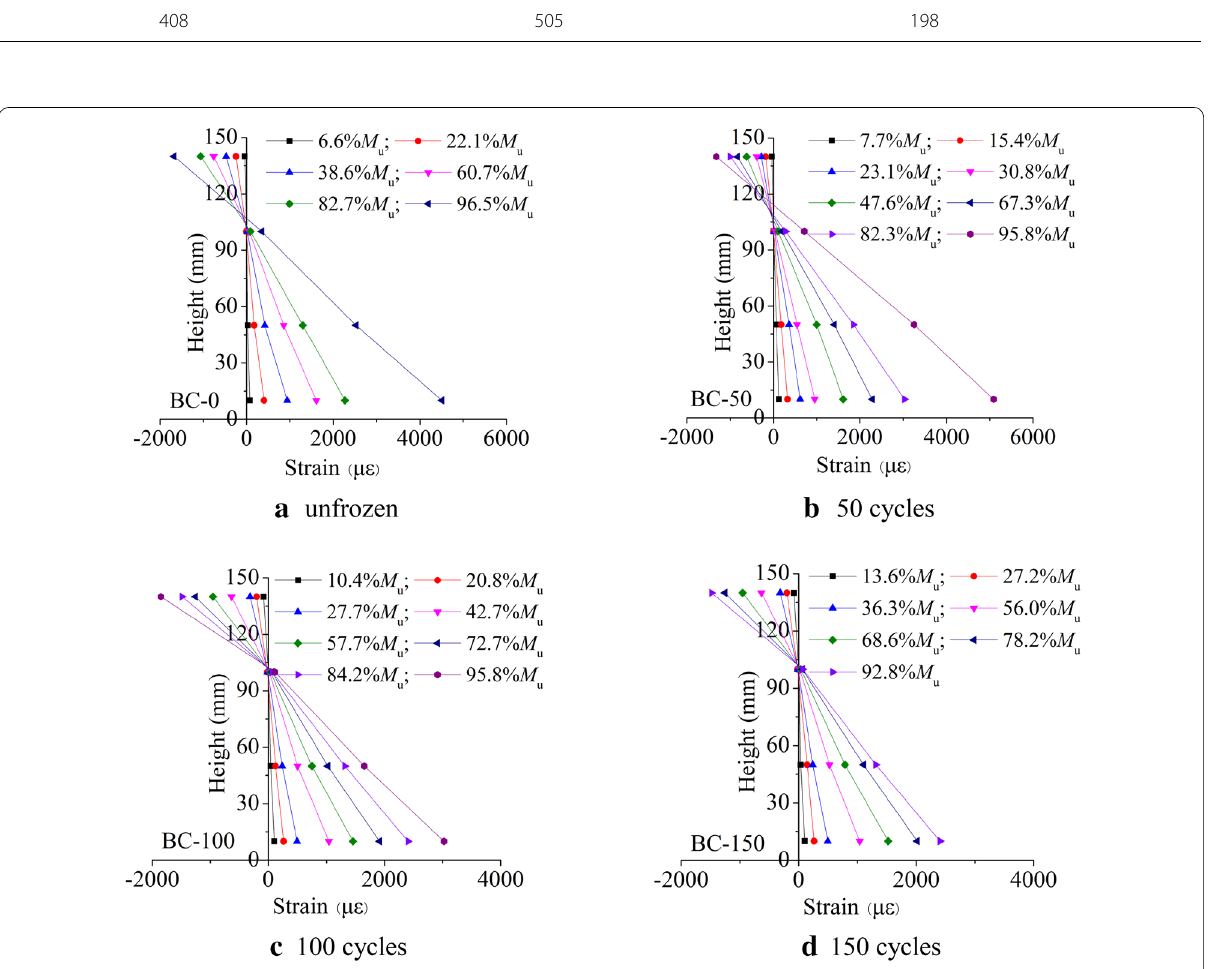
Fig. 3 Cross-section average strain